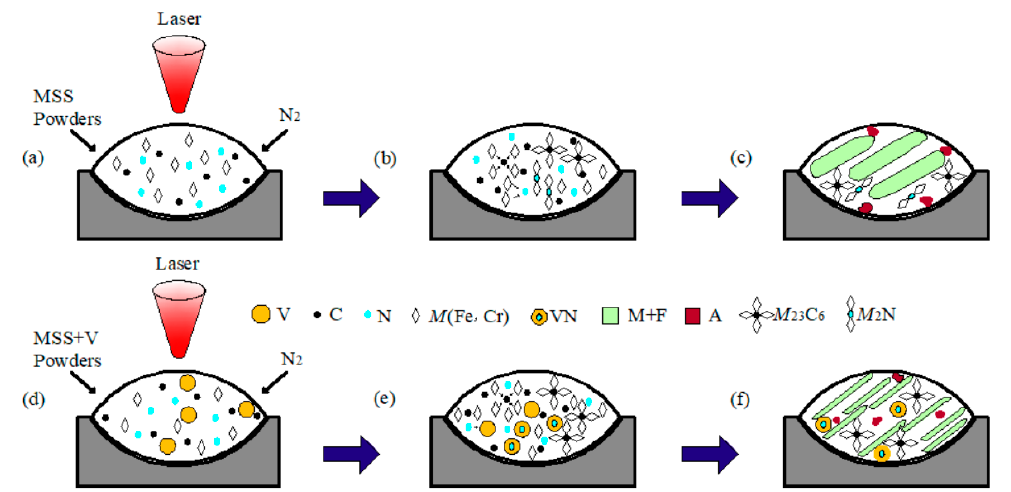
Figure 6. Schematic illustration showing the formation mechanism of the composite particles fabricated by laser cladding: ( a ) MSS powders; ( b ) formation of M 23 C 6 and M 2 N particles; ( c ) microstructure in the V-free coating; ( d ) V-bearing NSS powders; ( e ) formation of M 23 C 6 and VN particles; and ( f ) microstructure in the V-bearing coating.